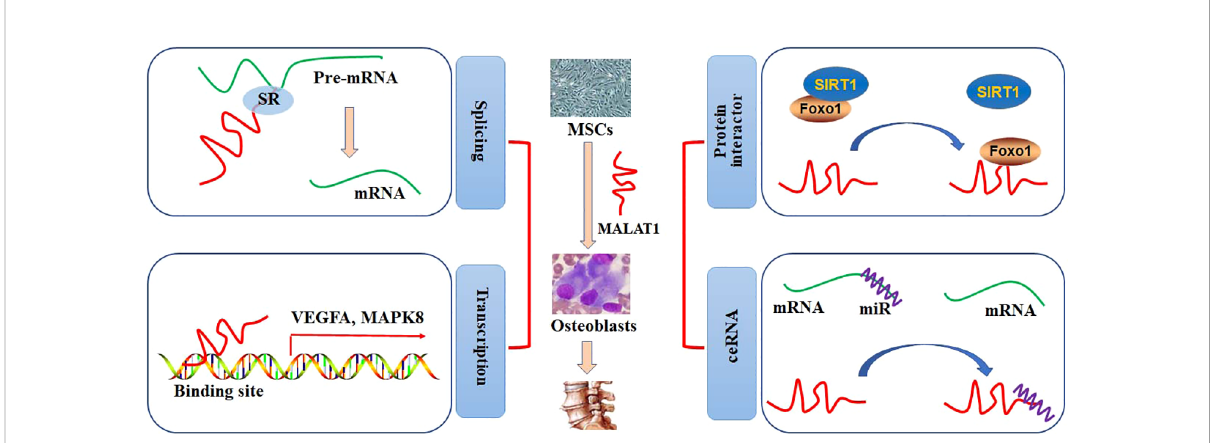
FIGURE 1 The roles of MALAT1 in bone and cartilage diseases. The regulatory activities of MALAT1 in osteogenic differentiation can be performed by mediating splicing and transcription and acting as a protein interactor or